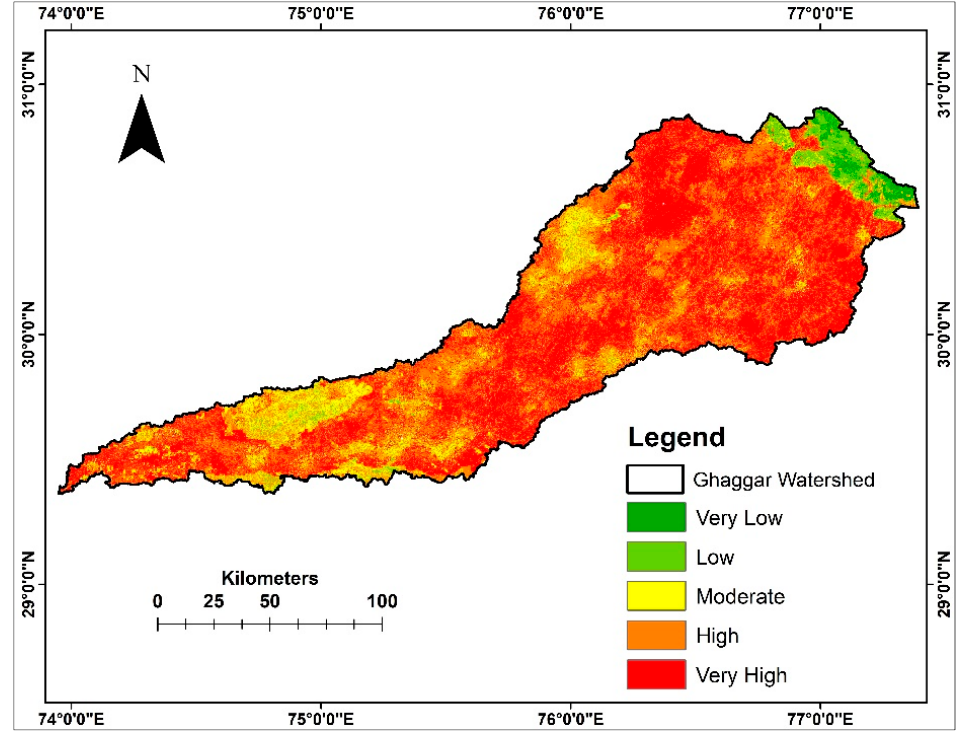
Figure 14. Groundwater potential zone map of the study area. Table 8. Pixel-based analysis for ground water potential (30